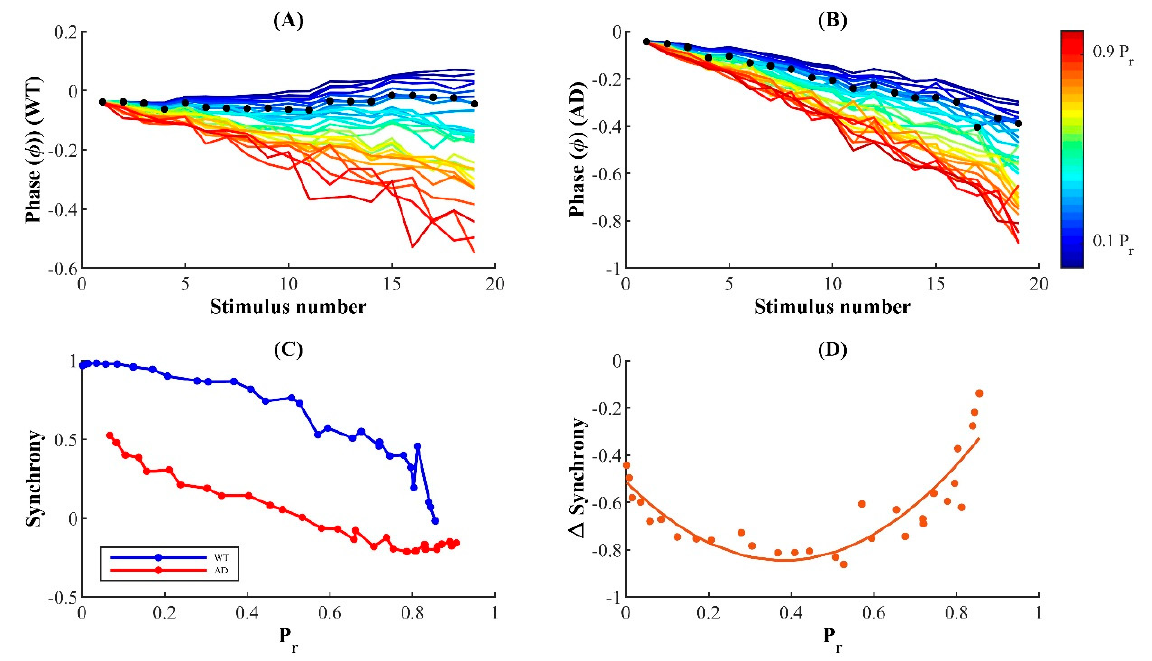
Figure 8. AD − related Ca 2+ disruptions impair spike–SVR synchrony: The phase of individual release events with respect to AP in WT ( A ) and AD − affected ( B ) synapses over a wide range of P r values. Black dots indicate the event phases corresponding to 35 VGCCs with initial P r during pulse train (P r1 ) equal to 0.14; ( C ) Synchrony of release event in response to the preceding pulse in WT and AD − affected synapses; ( D ) The magnitude of relative synchrony change from WT to AD conditions as a function of initial release probability during prolonged stimulation.